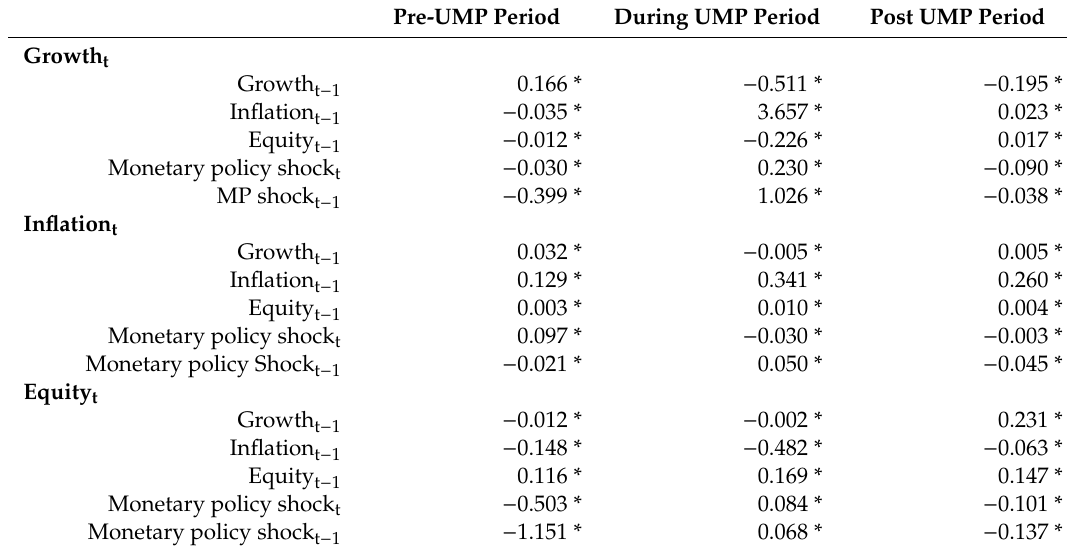
Table 3. Panel VARX estimations for equity prices. VARX: panel vector autoregression with exogenous variables.